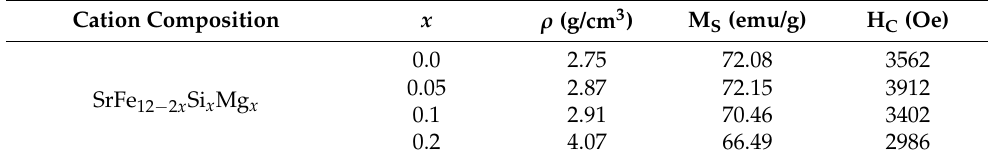
Figure 2. ( a ) Magnetic hysteresis curves of the SrFe 12 − 2 x Si x Mg x O 19 ( x = 0.0, 0.05, 0.1, 0.2) samples sintered at 1230 ◦ C and ( b ) plots of M S and H C vs. x . Table 1. Sintered sample densities ( ρ ), saturation magnetization (M S ), and coercivity (H C ) values of the SrFe 12 − 2 x Si x Mg x O 19 ( x = 0, 0.05, 0.1, 0.2) samples sintered at 1230 °C. The M S value is defined as the magnetization (M) value at H = 25 kOe.